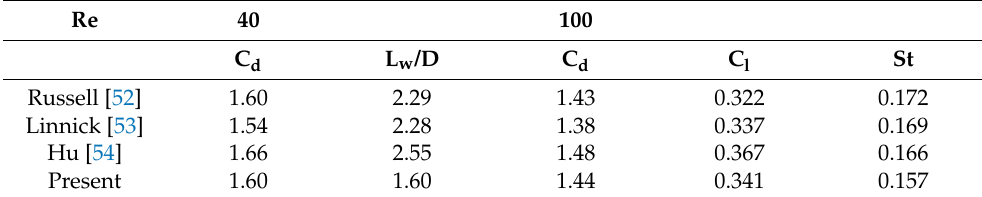
Figure 9. The flow field and streamline around a cylinder. ( a ) Re = 40; ( b ) Re = 100.